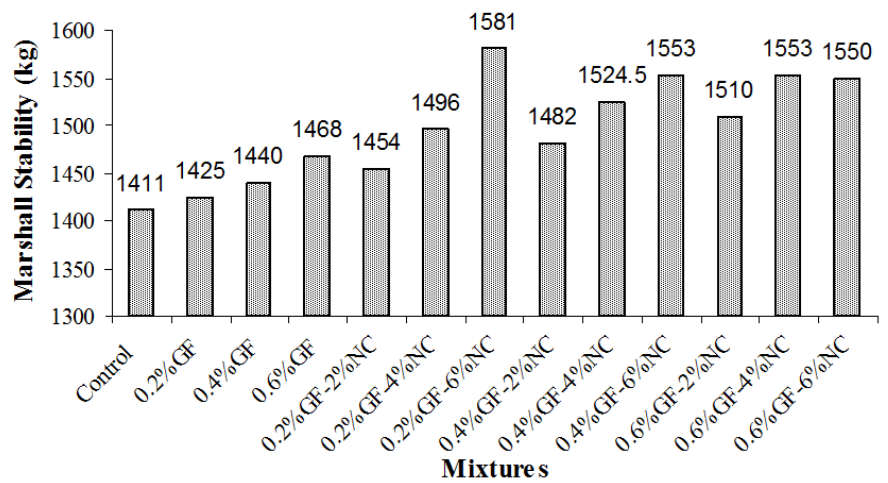
Fig. 2. Marshall stability of